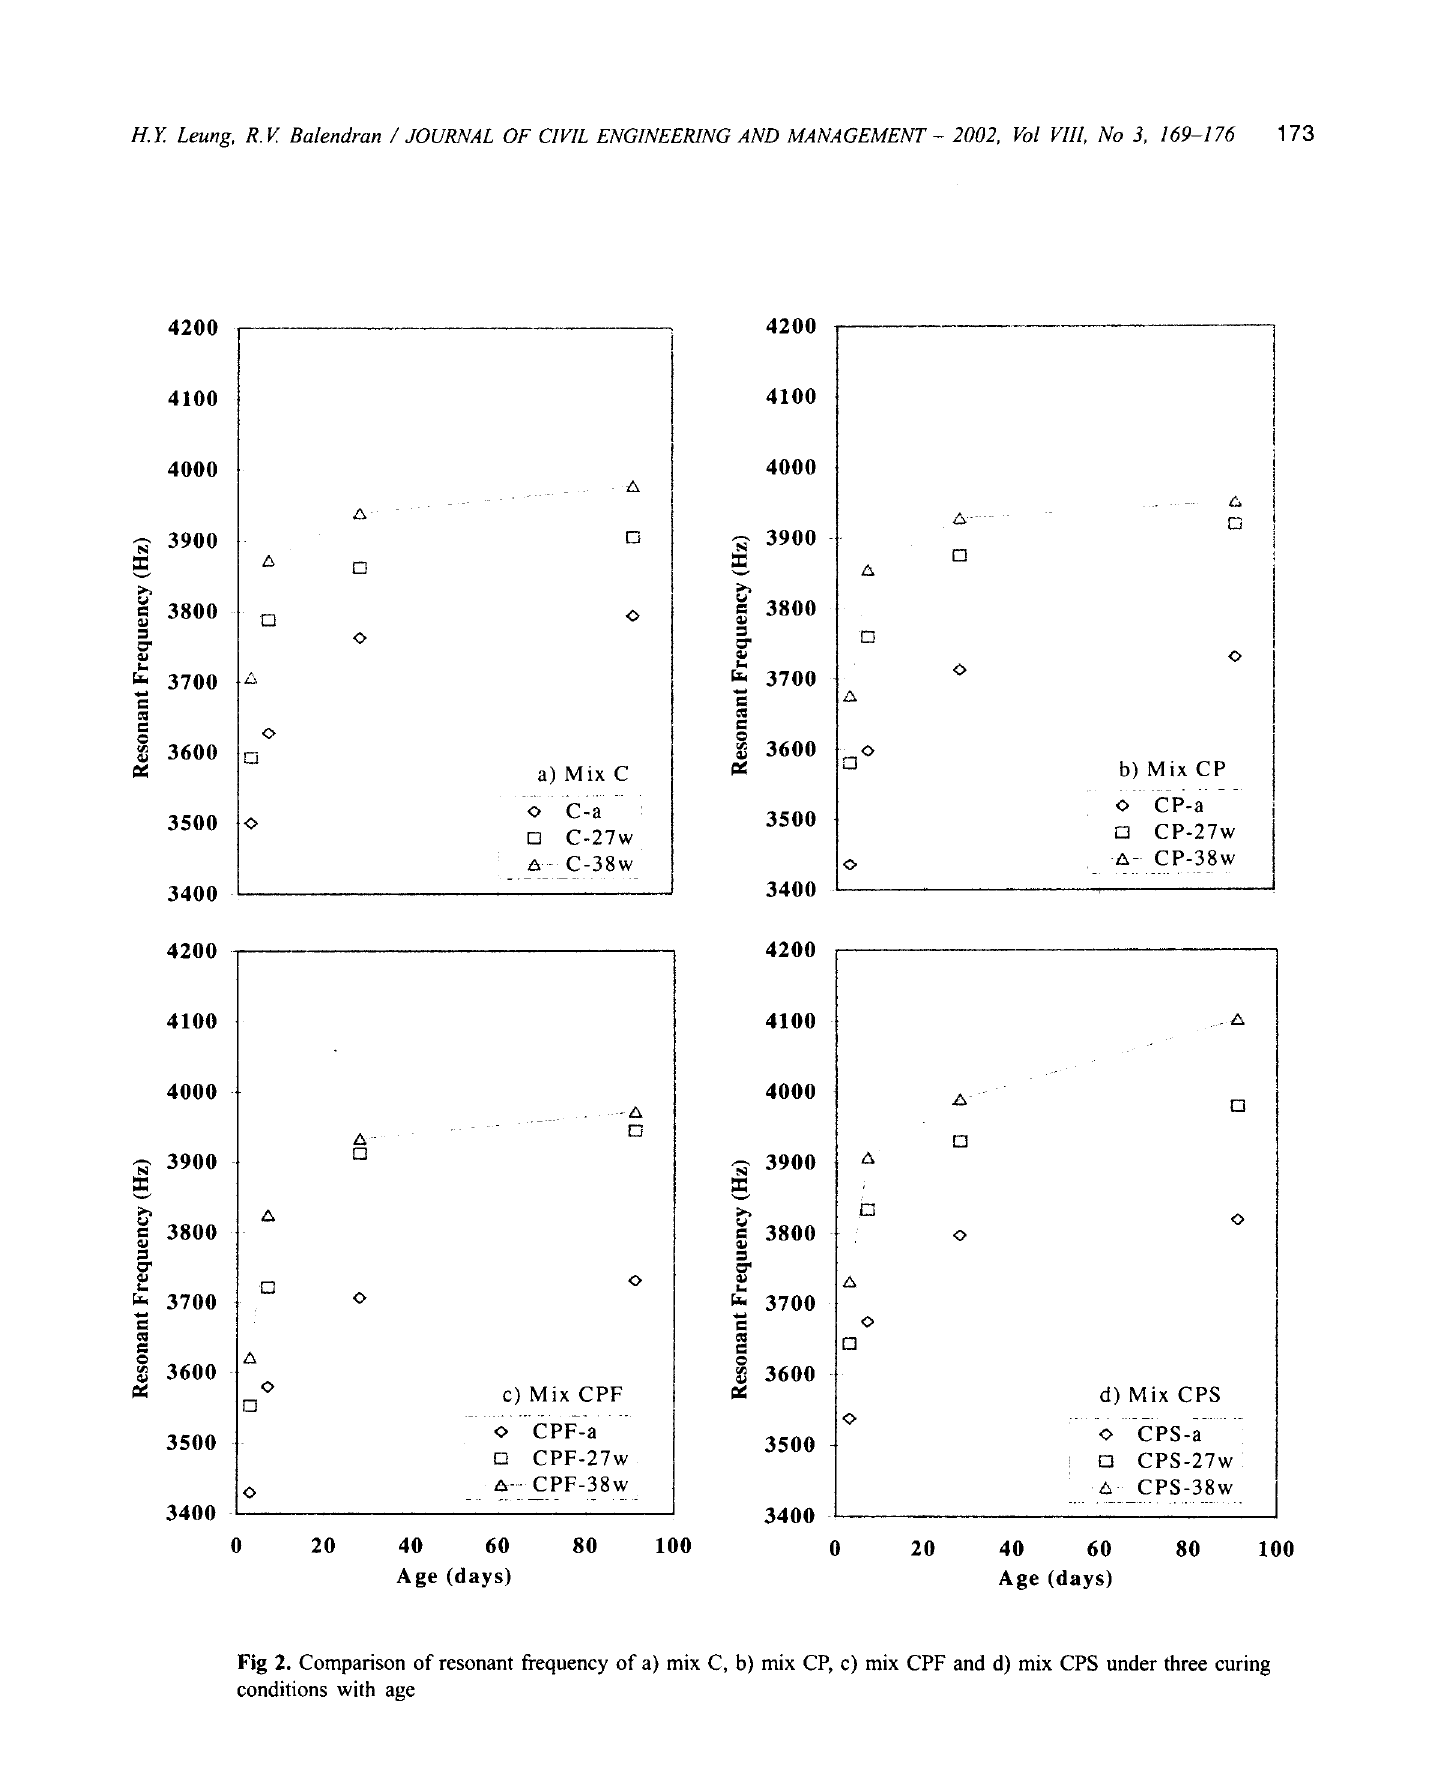
Fig 2. Comparison of resonant frequency of a) mix C, b) mix CP, c) mix CPF and d) mix CPS under three